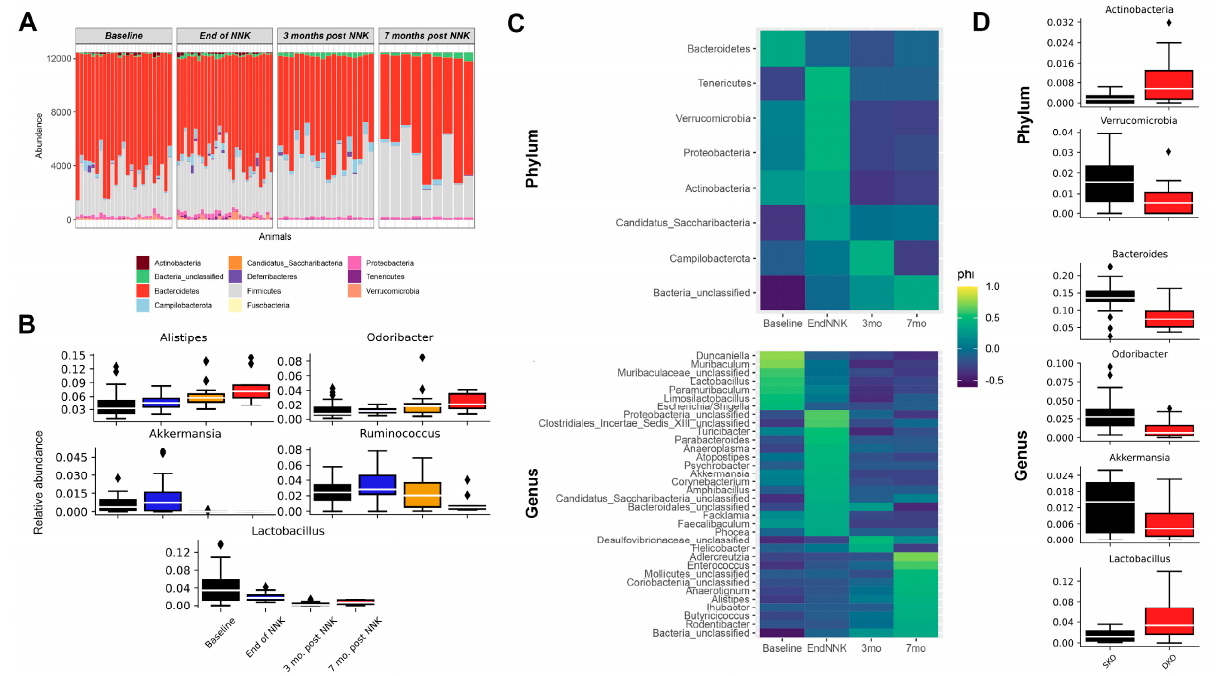
Figure 5. Global fecal microbiome changes associated with Lcn2 expression during lung oncogenesis. ( A ) Changes in abundance of bacterial phyla at different timepoints of NNK exposure Gprc5a − / − ; Lcn2 − / − . ( B ) Changes in gut select bacterial genera at different timepoints of NNK exposure